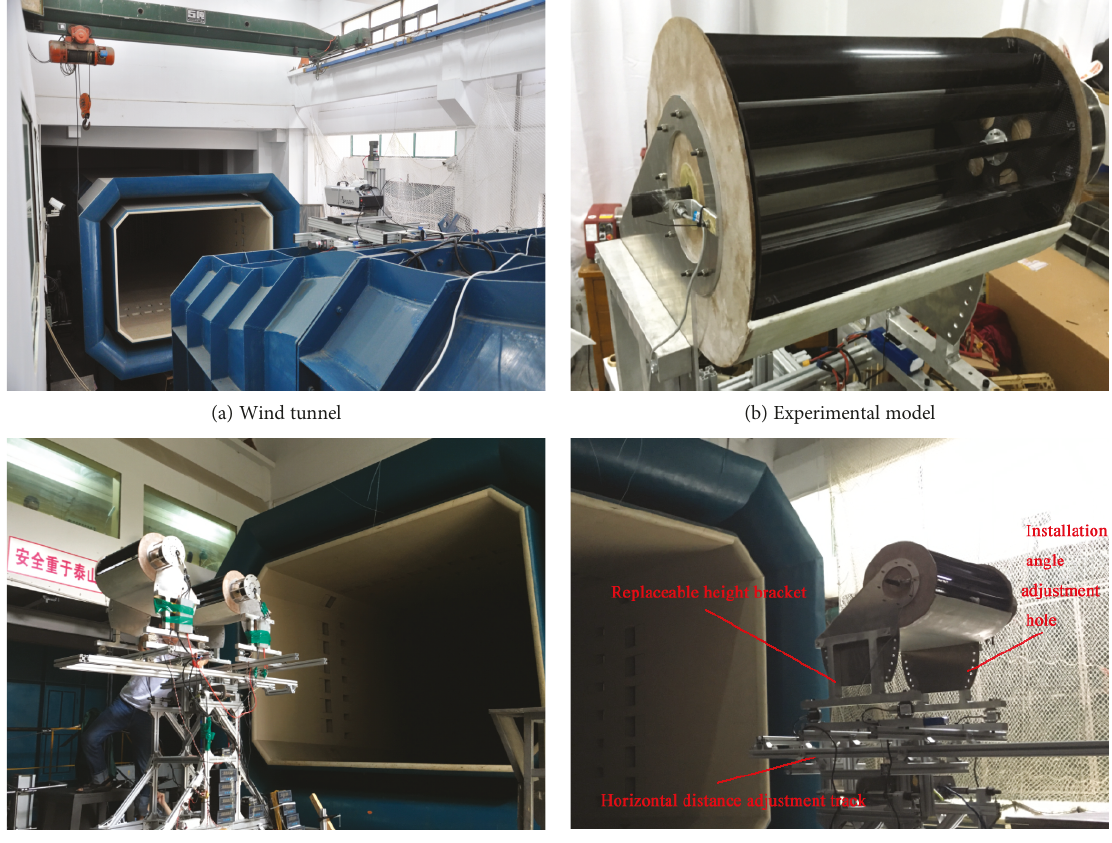
Figure 20: Experimental model and